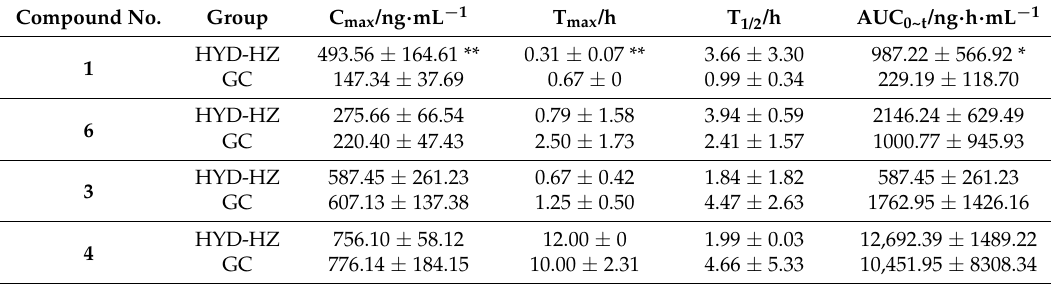
Table 8. Comparison of the Pharmacokinetic Profile of the GC and HYD-HZ Groups. Compound No.